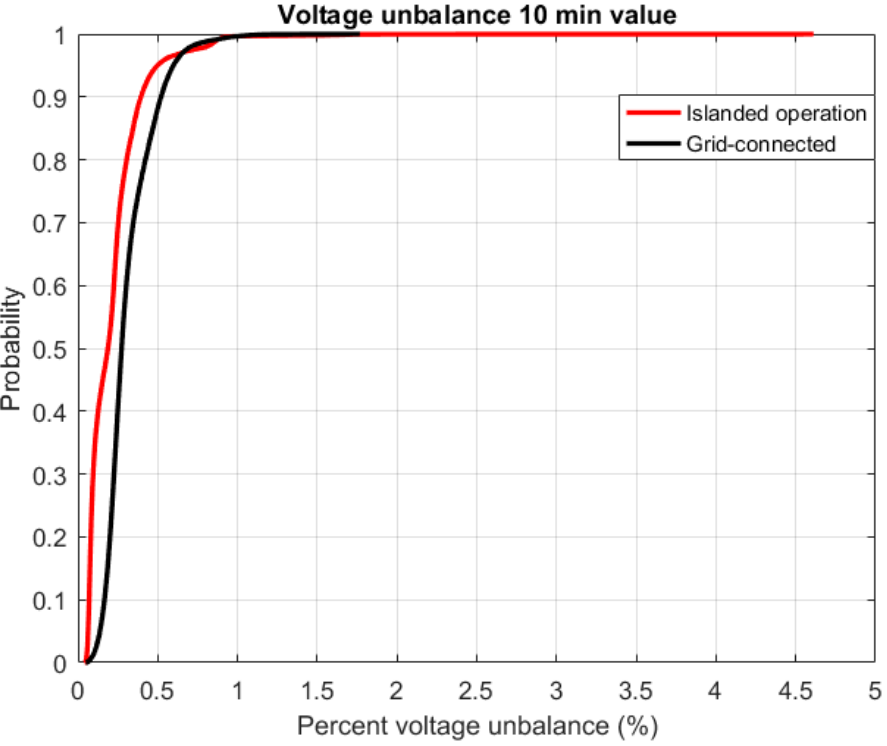
Table 3 . 95% confidence interval, the maximum 10 min value and total average value for all three phases in islanded and grid-connected operation.